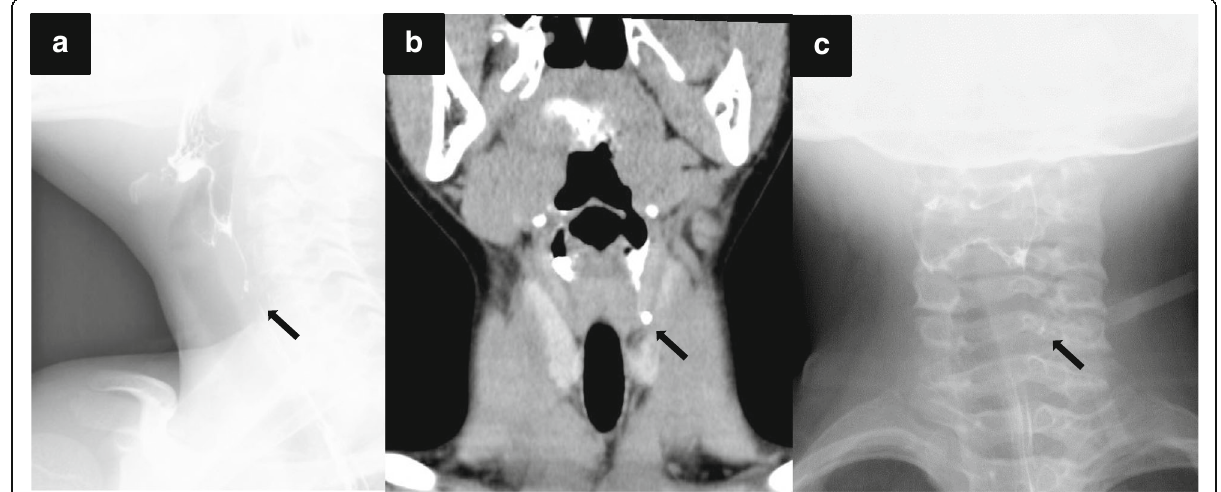
Fig. 2 a Barium esophagography shows a pyriform sinus fistula (arrow) on the left side. b Oral contrast coronal computed tomography shows a fistula (arrow). c Barium esophagography after open neck surgery shows recurrence of the pyriform sinus fistula (arrow)